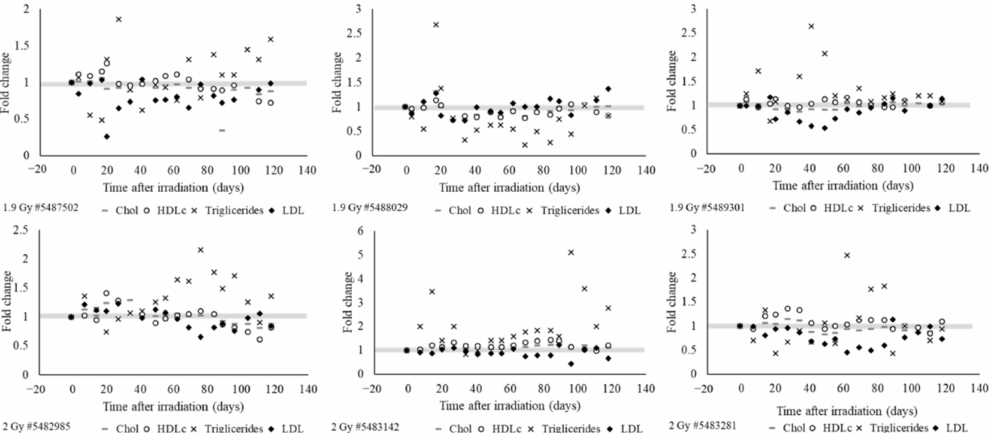
Figure 6. Longitudinal analysis of plasma lipid profiles in irradiated animals. Cholesterol, HDL, LDL, and triglyceride levels from individual animals were normalized to pre-irradiation levels and plotted over time. The grey box represents the pre-irradiation value measured for each